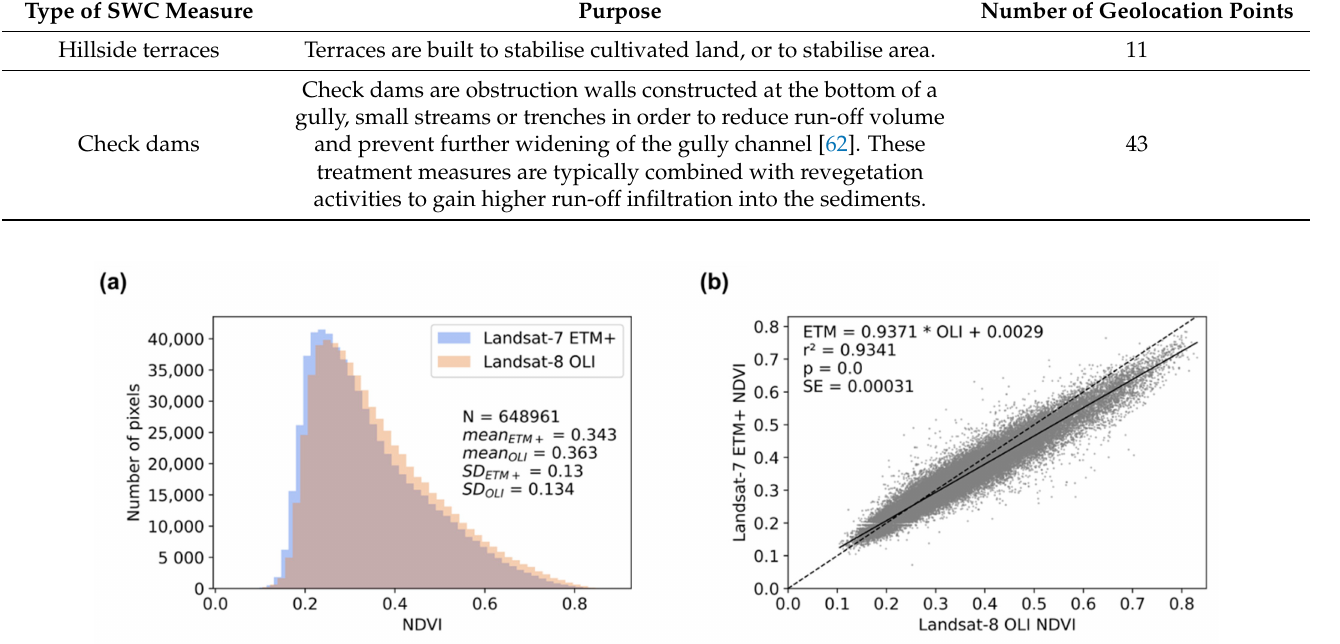
Figure A1. Landsat cross-calibration. ( a ) Distributions of ETM+ and OLI NDVI values; ( b ) OLS regression of ETM+ NDVI against OLI NDVI values. For a given OLI NDVI value, the corresponding ETM+ value is usually